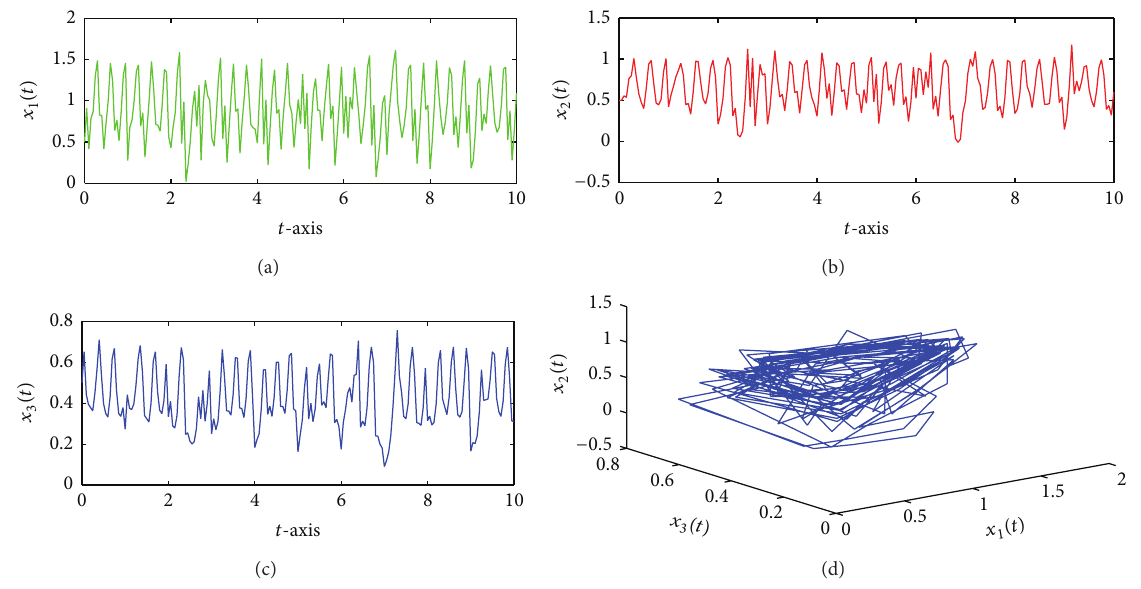
Figure 1: Dynamics of (42). (a) Time series of 𝑥 1 , (b) time series of 𝑥 2 , (c) time series of 𝑥 3 , and (d) portrait of (𝑥 1 ,𝑥 2 , 𝑥 3 ) .